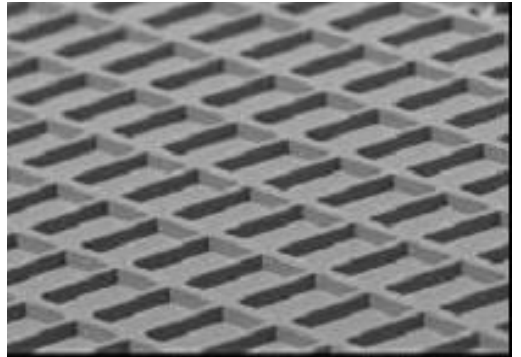
Figure 10. The image of rib on Indium Tin Oxide (ITO)